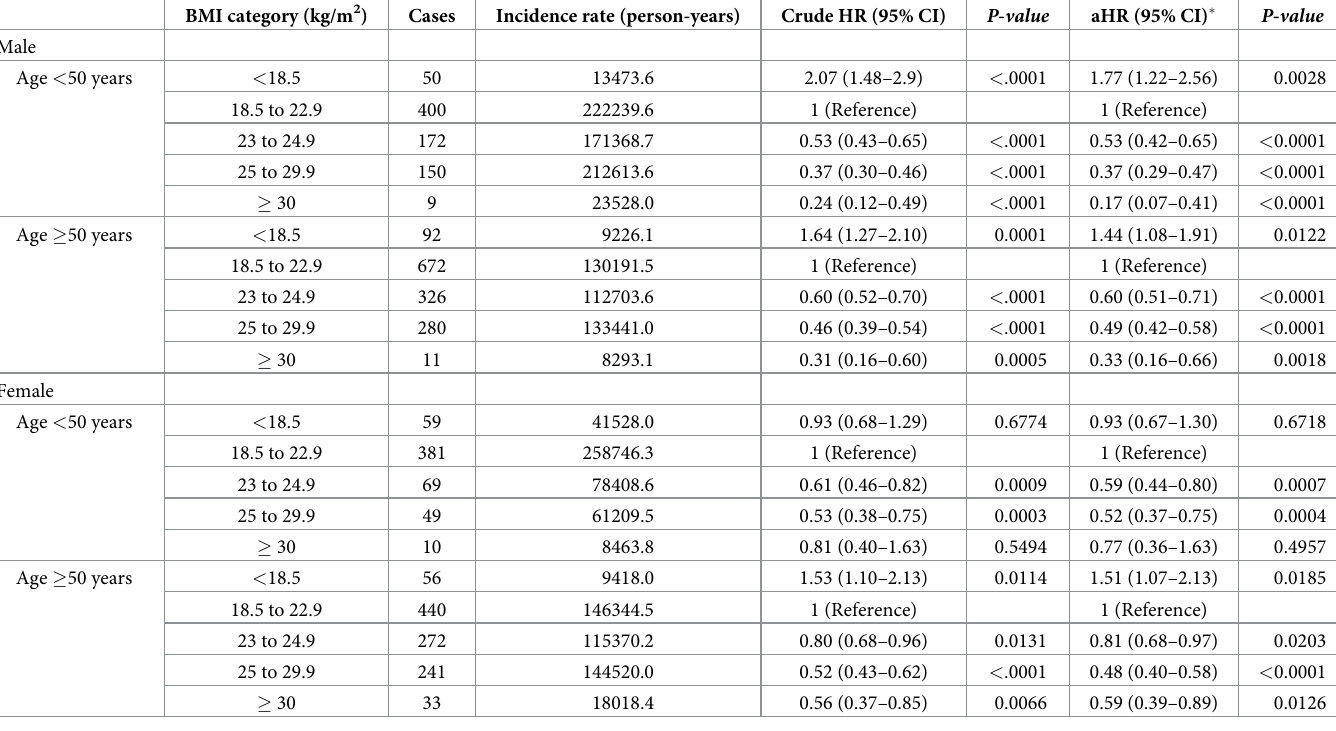
Table 3. Effect of BMI: Subgroup analysis by sex and